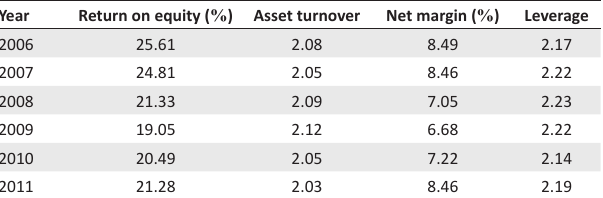
TABLE 2: Company financial performance (mean). Year Return on equity ( % ) Asset turnover